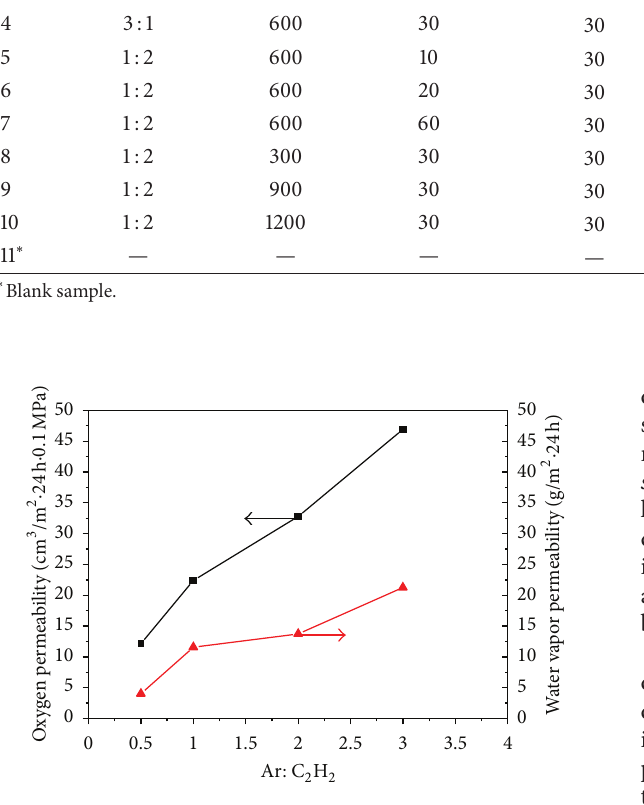
Figure 5: Barrier properties under different Ar:C 2 H 2